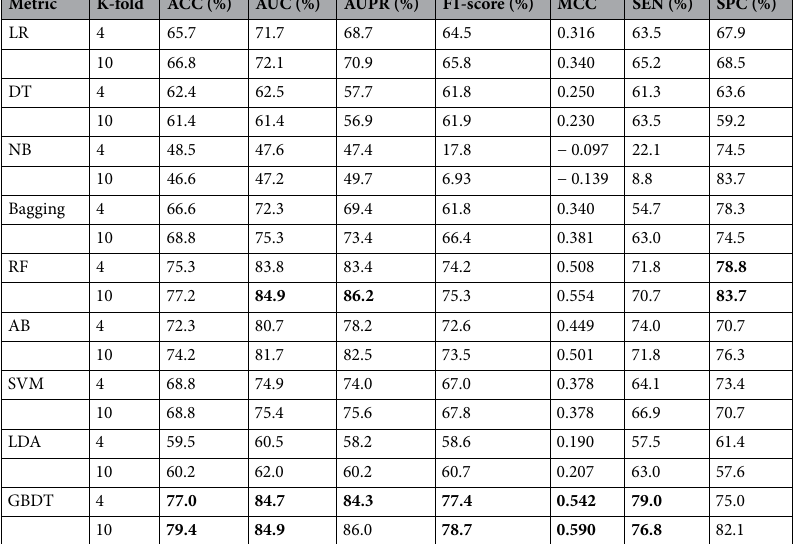
Table 8. The performance evaluation of the proposed system based on the GBDT compared with state-of-the- art classifiers using 4-fold and 10-fold cross-validation techniques on the protein dataset. Significant values are in bold.